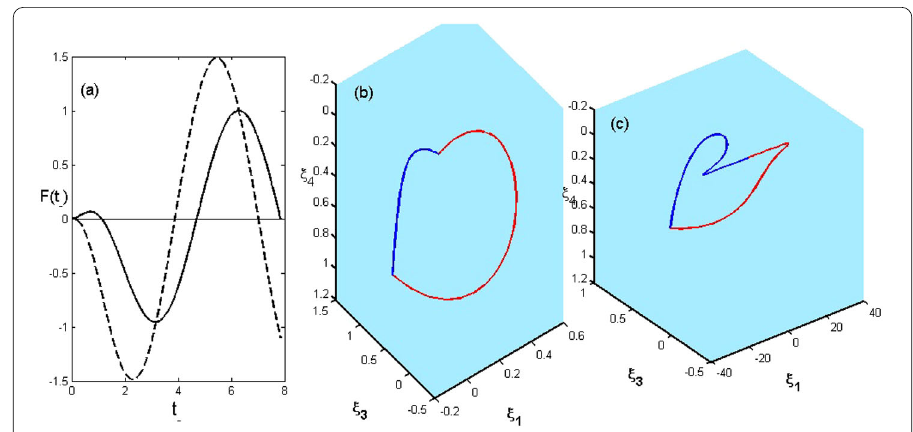
Figure 7 ( a ) The behavior of equation (14) for different values of σ . ( b ), ( c ) Short and long time periods ( t – = 1.6954, t – = 3.7296),